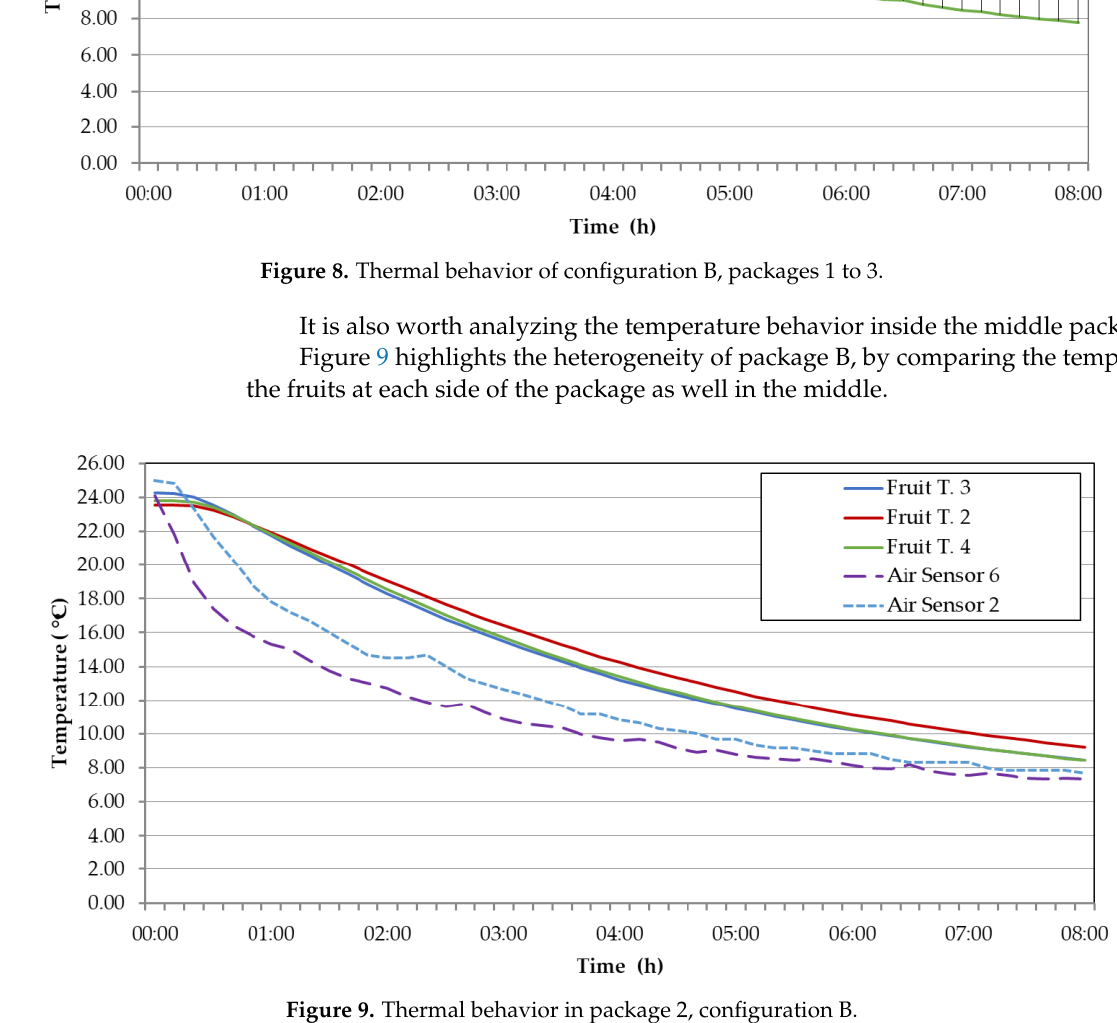
Figure 8. Thermal behavior of configuration B, packages 1 to 3.